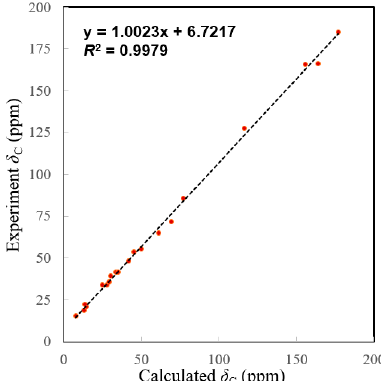
Figure 5. ( a ) Experimental and calculated ECD spectra of 1 ; ( b ) Experimental and calculated ECD spectra of 2 .